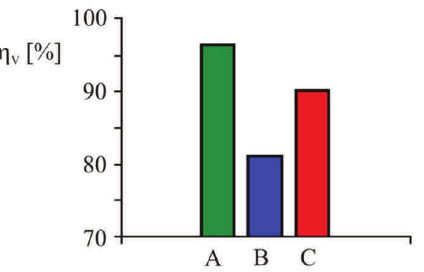
Fig. 6. The volumetric efficiency ( η v ) by the type of inlet channel [10]: A – helical, B – spiral, C – spirally-helical (comp. Fig. 5)